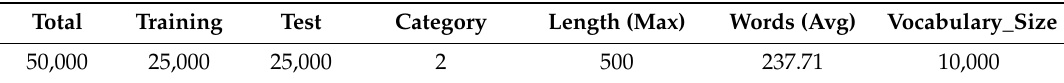
Table 1. Data set.